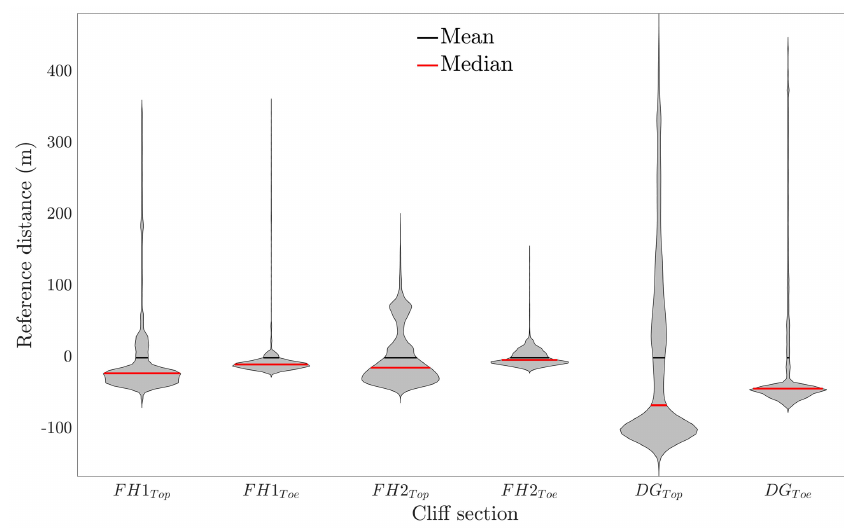
Figure 13. Distance from participant cliff lines to the mean reference lines for each section.